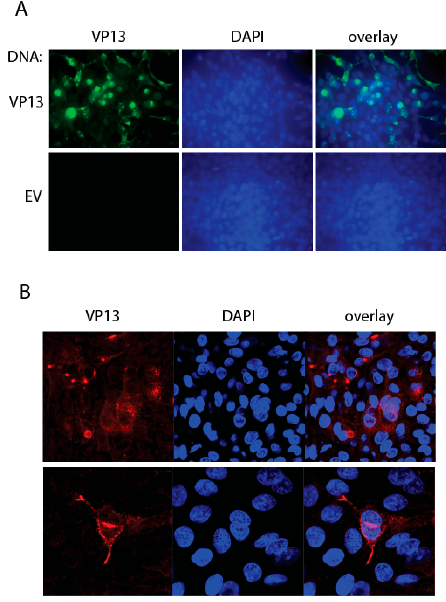
Figure 5. Detection of the linear epitope in HEV ‐ infected cells by immunofluorescence assay (IFA). ( A ) IFA of HEK293 cells transfected with VP13 plasmid or empty vector (EV). Green fluorescence on the left panel indicates VP13 protein. Nuclear DNA shown in the middle panel was counterstained with 4 ′ 6 ′‐ diamidino ‐ 2 ‐ phenylinodole (DAPI, blue fluorescence). An overlay is shown on the right; ( B ) Detection of the VP13 epitope in HEV ‐ infected S10 ‐ 3 cells. The cells were transfected with HEV Sar55 RNA. Red fluorescence on the left panel indicates VP13 protein. Nuclear DNA shown in the middle panel was counterstained with DAPI (blue fluorescence).